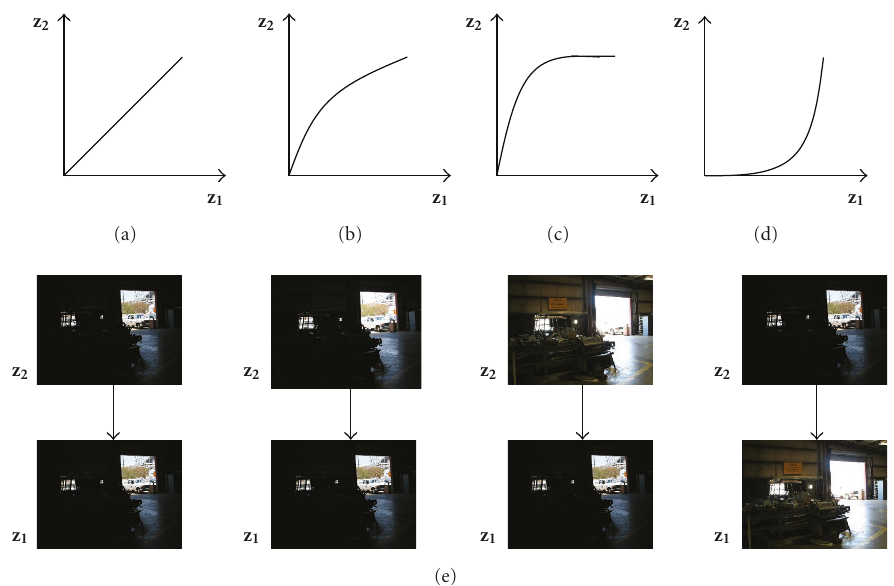
Figure 3: Various photometric conversion scenarios. First row illustrates possible photometric conversion functions. Second and third rows show example images with such photometric conversion.